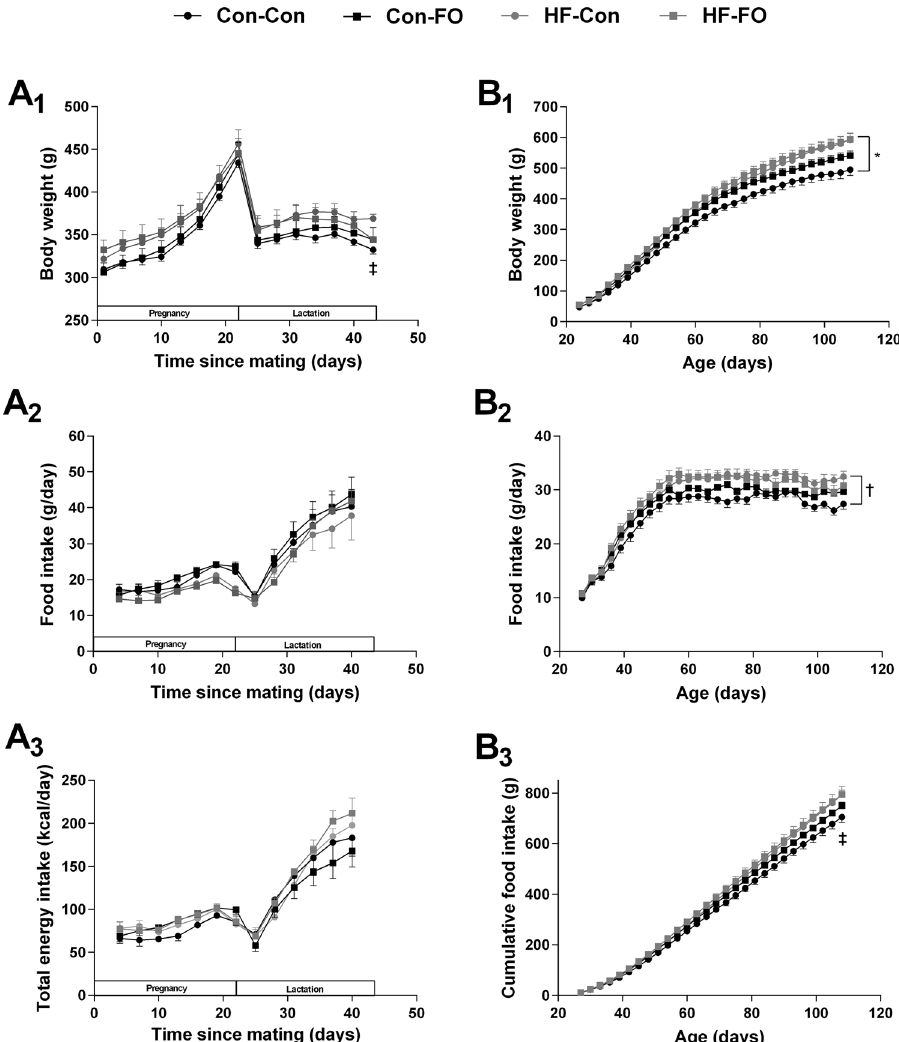
Figure 2. Weight, food consumption, and energy intake in rat dams ( A ) and male offspring ( B ) according to the maternal diet (control or high-fat) and gavaged treatment during pregnancy [fish oil or control (water)]. A: body weight (A1), food consumption (A2), and total energy consumption including diet and gavaged oil (A3) of dams from mating (day 0) through to weaning (day 40). B: body weight (B1), food consumption (B2), and cumulative food consumption of male offspring from weaning through to termination (day 110) (B3). Error bars represent standard errors; * p < 0.05 for a difference in weight between Con-Con and HF-Con groups across the life span; † p < 0.05 for a difference in food intake between Con-Con and HF-Con groups from day 60 when intake stabilized; ‡ p < 0.05 for a difference between Con-Con and HF-Con groups at